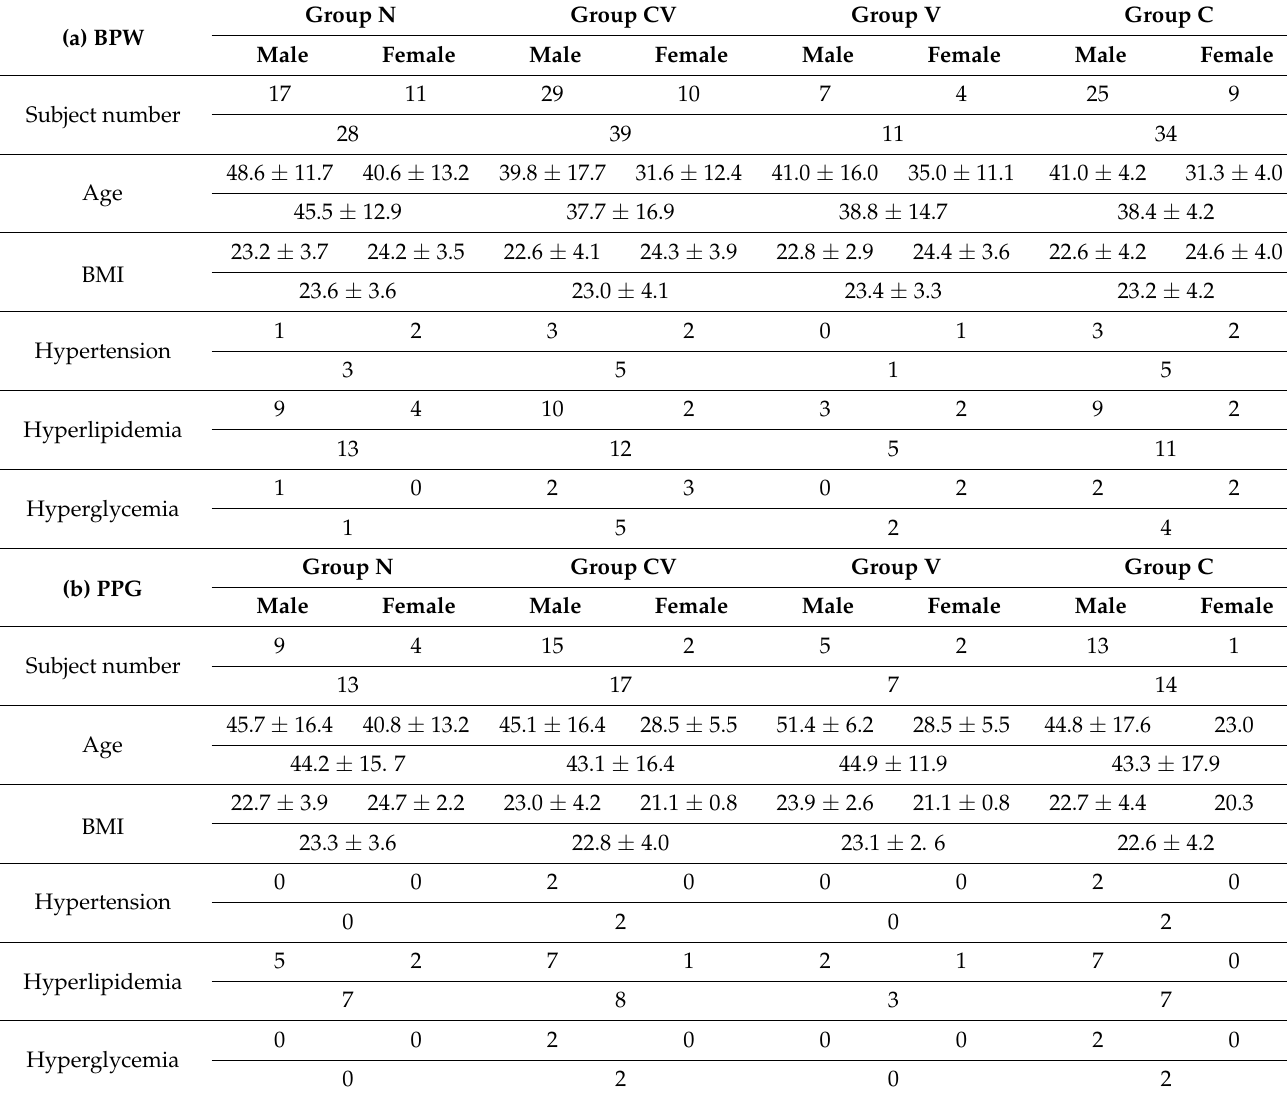
Table 1. Characteristics of the study subjects in Groups N, CV, V, and